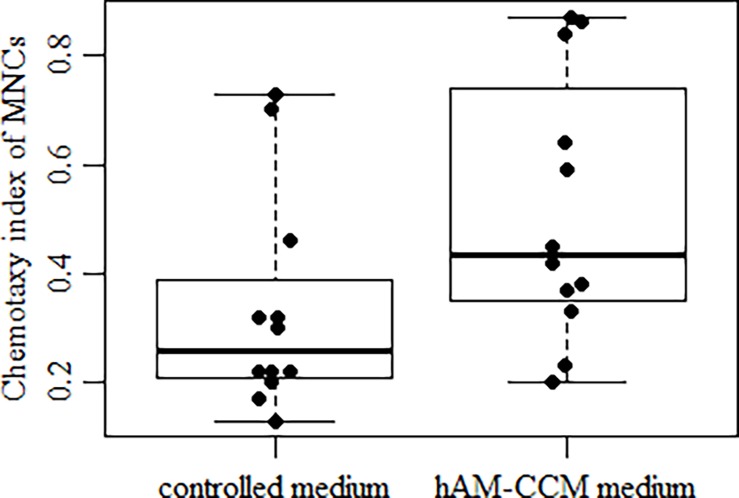
Effect of hAM CCM on chemotaxy indeks of BM MNCs.The chemotaxy index (CI) after 2.5 h at 37°C incubation time was calculated by dividing the number of cells in lower chamber by the number of cells added to the upper chamber counted at the start of the test. Median values and interquartile range (P25, P75) are shown (n = 12, p < 0.05).